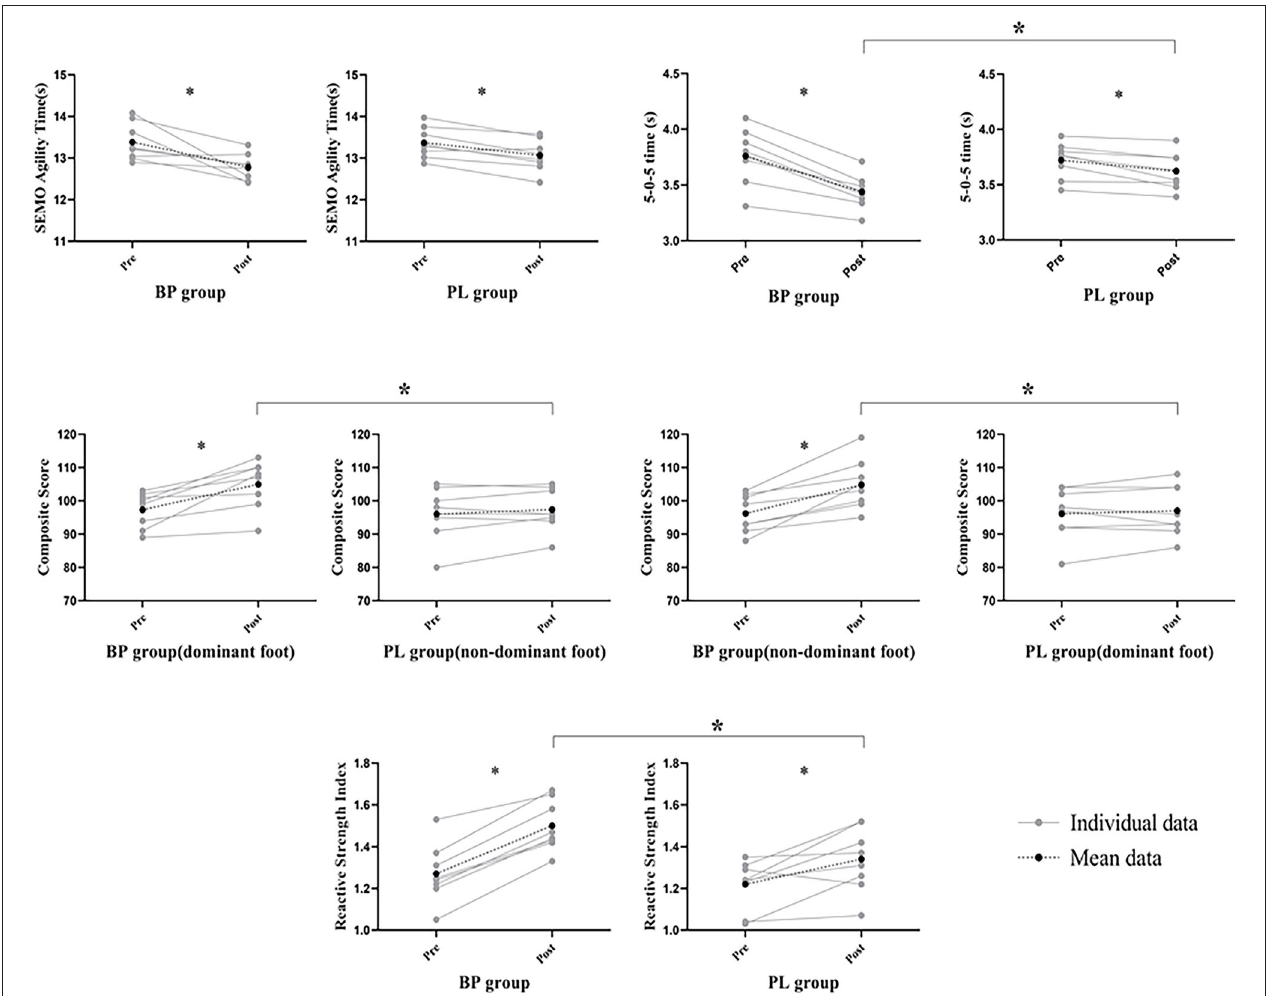
FIGURE 6 | Individual and mean values for agility related tests during before and after Balance-Plyometric (BP) and Plyometrics (PL) training. Note: * p < 0.05.